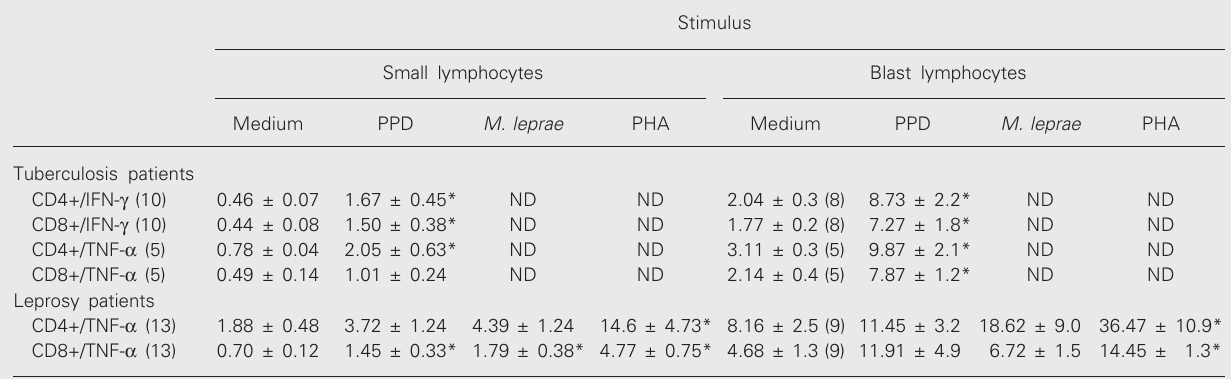
Table 1. Percentages of IFN- γ (16 h) and TNF- α (8 h) staining in CD4+ and CD8+ T cells following in vitro antigen stimulation of peripheral blood mononuclear cells from tuberculosis and leprosy patients.